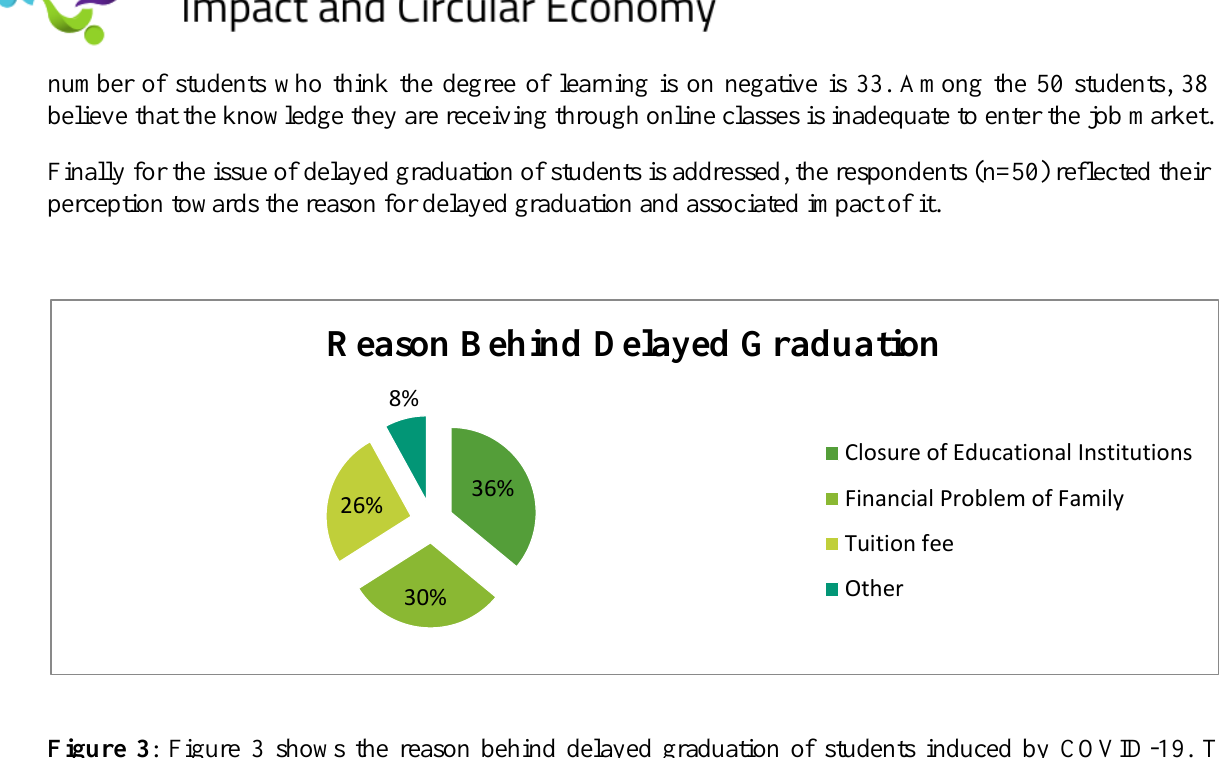
Figure 3 : Figure 3 shows the reason behind delayed graduation of students induced by COVID-19. The most prevalent reason identified by the majority of student (18) is the closure of educational institutions, followed by the second biggest reason financial problem of family induced by COVID-19 which is identified by 15 students.